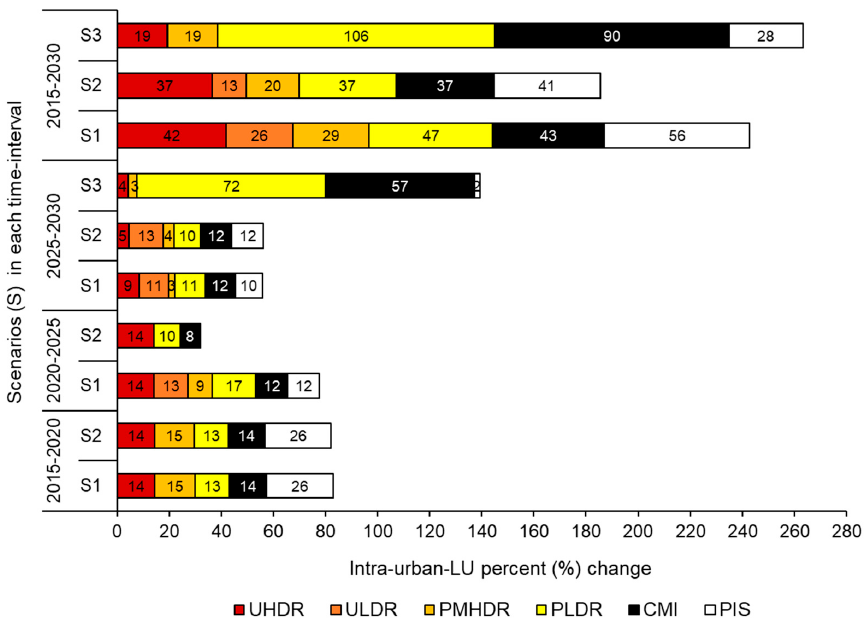
Figure 8. Percent change of each intra-urban-LU class for Lusaka city, Zambia, in each simulated time interval. Refer to Figure 7 for abbreviations.